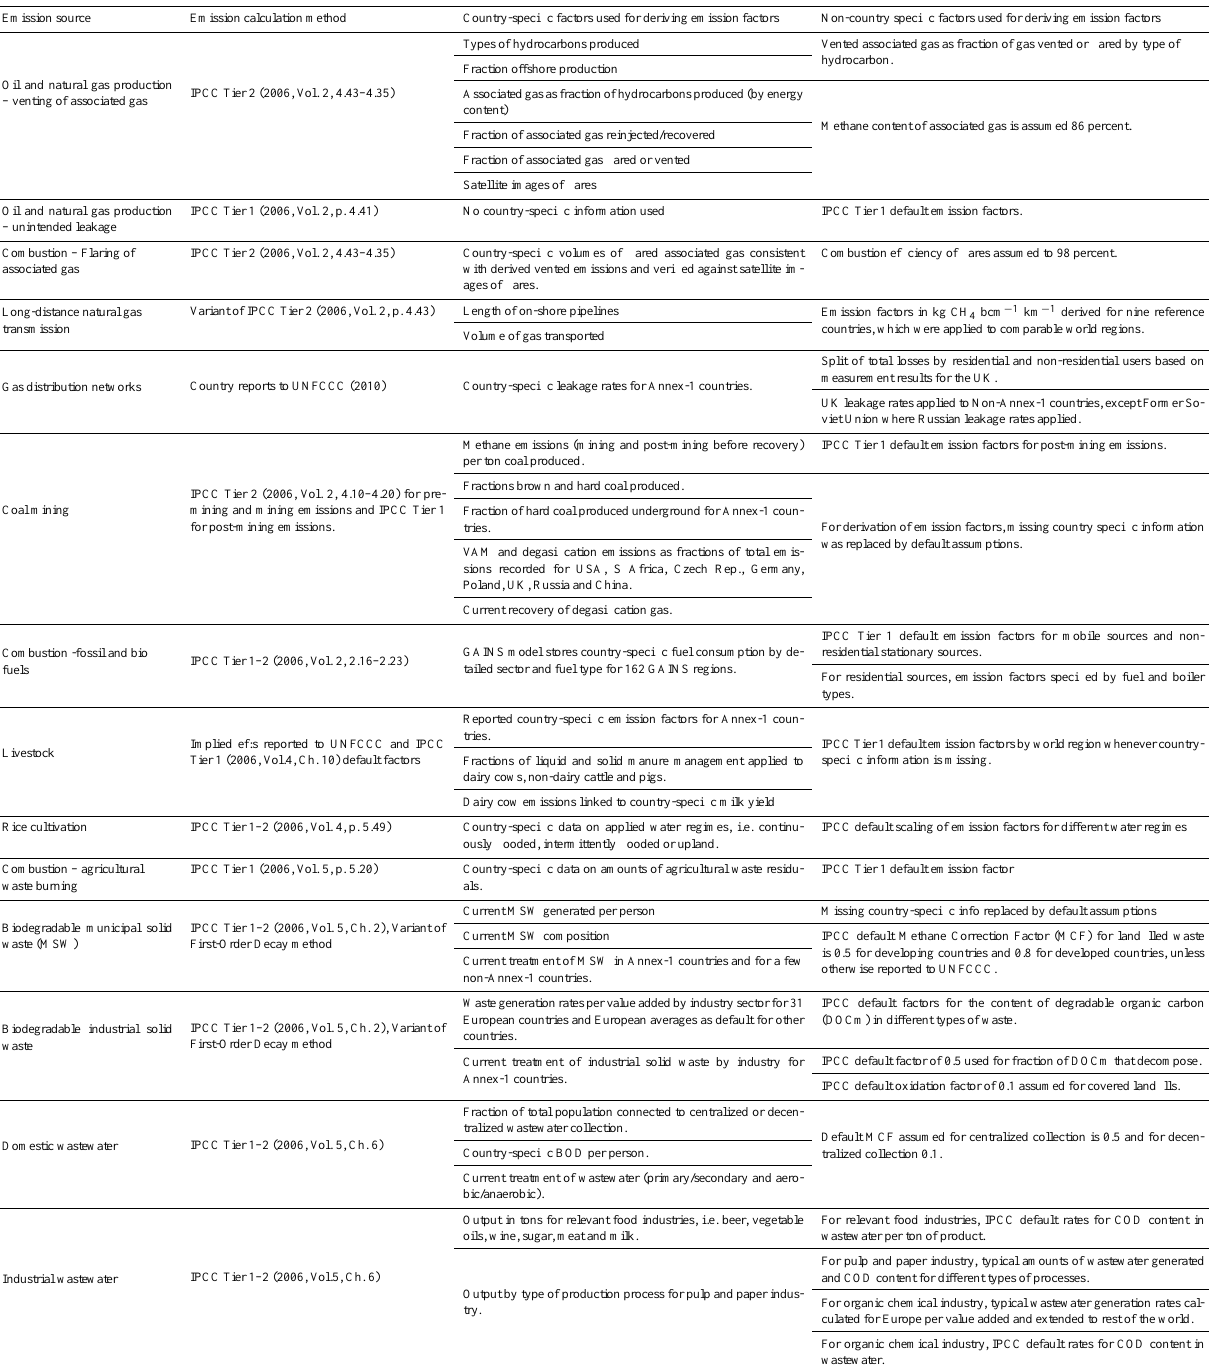
Table 2. Methodology for CH 4 emission estimations in the GAINS model (for references, see